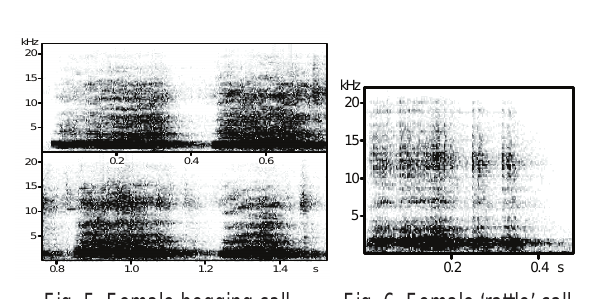
Fig. 4. Male contact calls